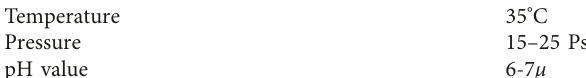
Table 3: Conditions for salt spray test.